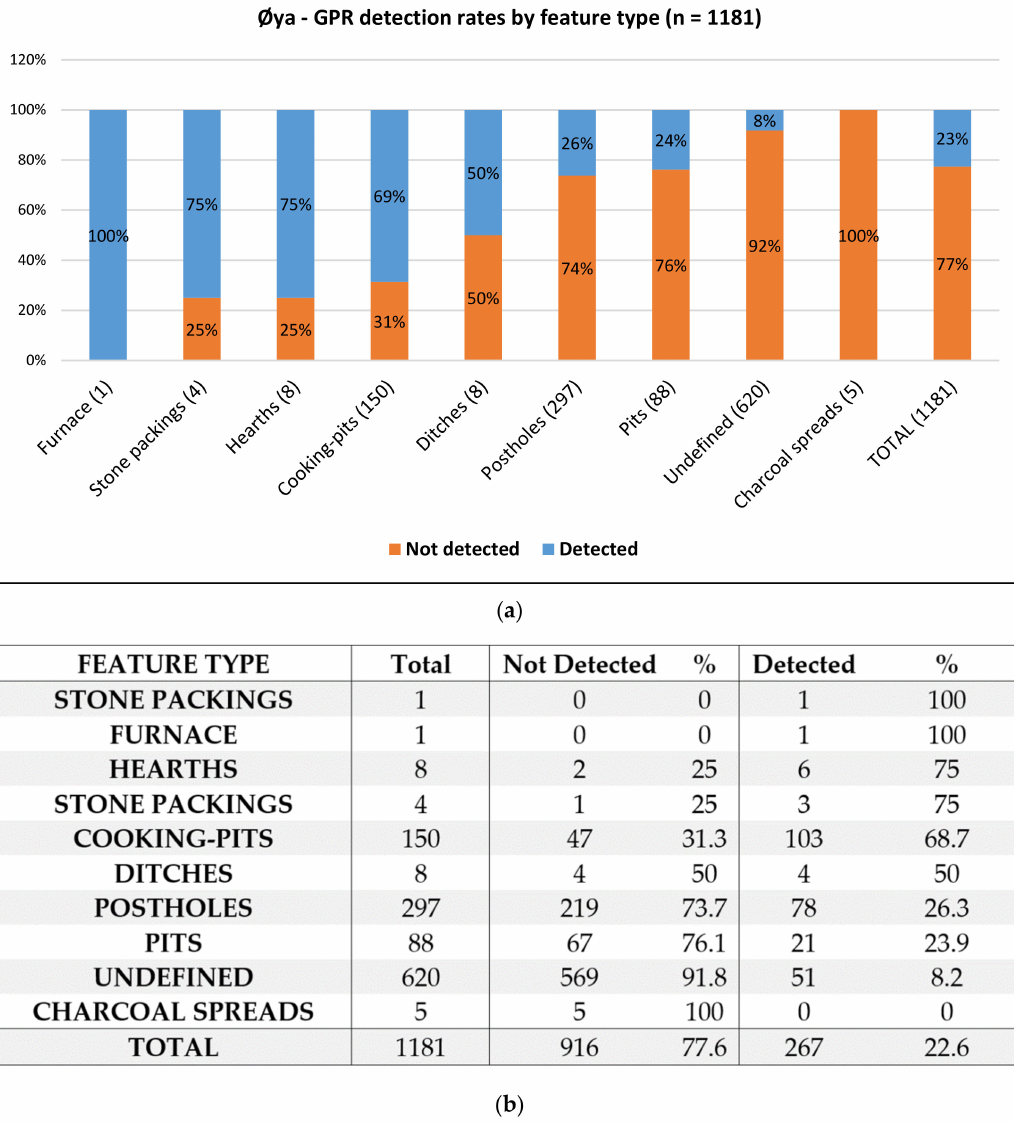
Figure 10. ( a , b ) Charts showing the GPR detection rate by feature type at